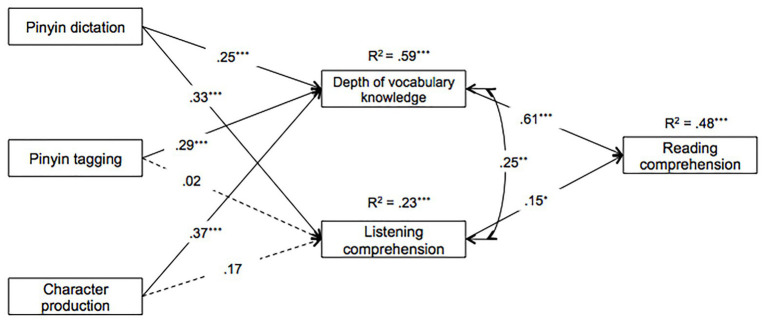
Path model for the relationship between Pinyin spelling and Reading Comprehension, including Depth of Vocabulary Knowledge and Listening Comprehension as two possible mediators (standardized estimates). Solid lines indicate significant paths and dashed lines indicate nonsignificant paths (*p < 0.05; **p < 0.01; ***p < 0.001).